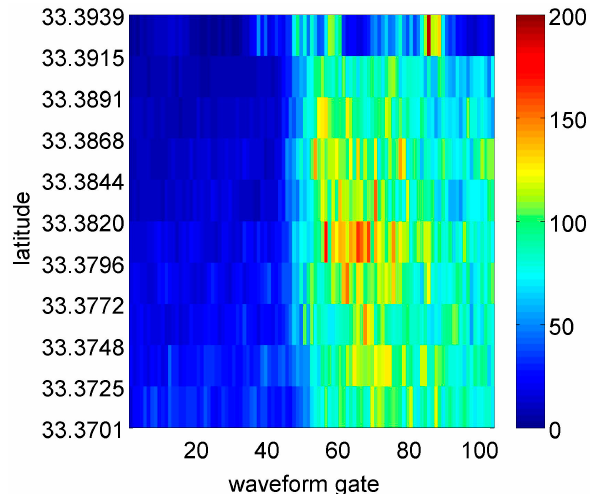
Figure 5. Sample of contaminated waveforms in Jason-2 data, demonstrated by the last cycle (#270) used in this study. The x-axis is the waveform gate from 1 to 104, and y-axis is the latitude of the ground track. Ten waveforms are stacked and color-coded in relative power units. The nominal tracking gate is 32.5.